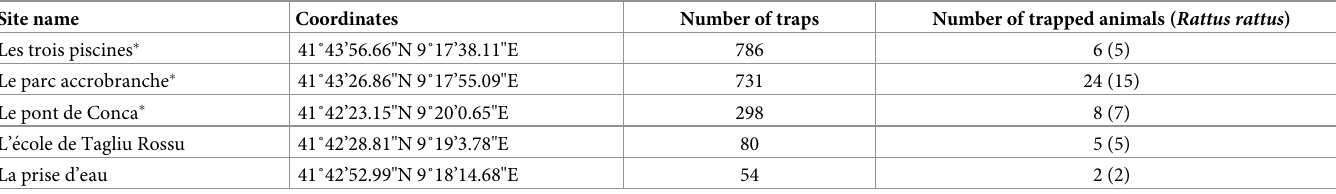
Table 2. Name, GPS coordinates and number of traps for each